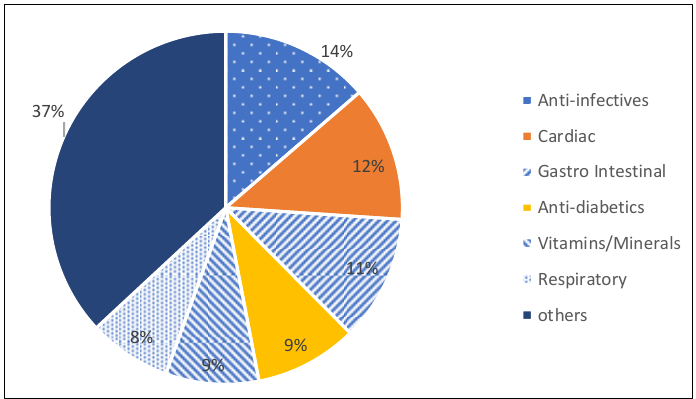
Figure 3. Pharmaceutical Market by Indication (IBEF Pharmaceuticals 2019 [13]).